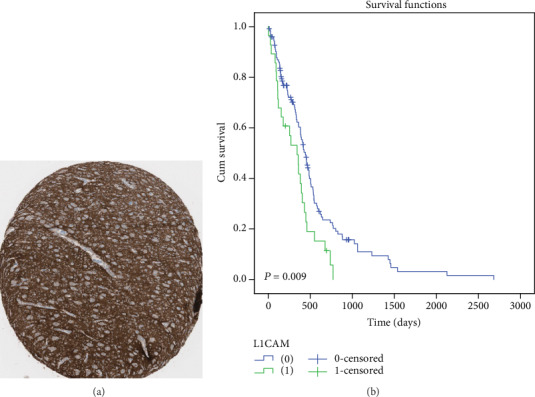
(a) L1CAM strong expression IHC images in HPA. Image was obtained from: https://www.proteinatlas.org/ENSG00000198910-L1CAM/pathology/tissue/glioma#img. (b) Prognostic values of L1CAM' mRNA expression in 153 glioblastoma patients in TCGA, for L1CAM high expression patients (FPKM cutoff value = 5.9) with a poor prognosis (p = 0.009).